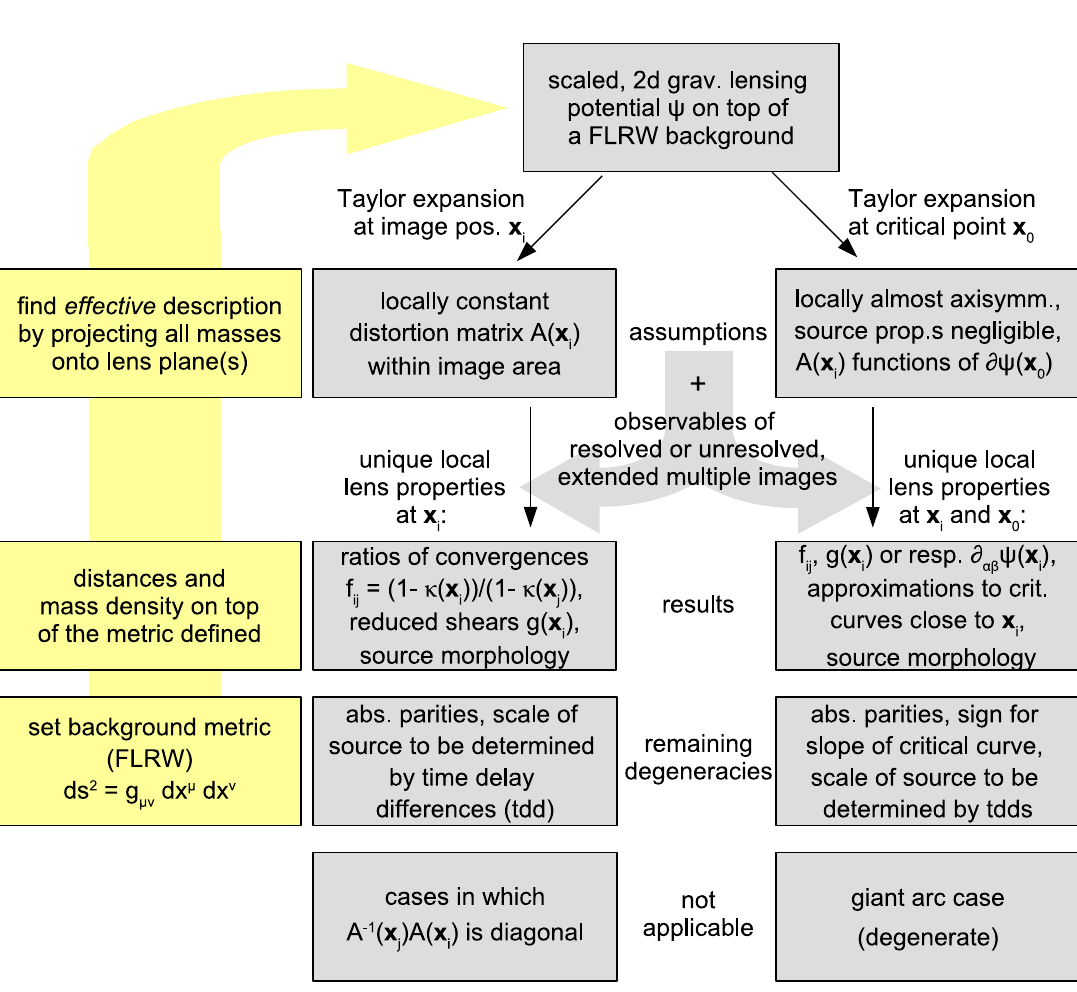
Figure 8. Summary of our approach as outlined in Section 2, its prerequisites (yellow boxes), working principles and resulting lens properties (grey boxes). Each result also has its remaining degeneracies and there are cases to which the approach cannot be